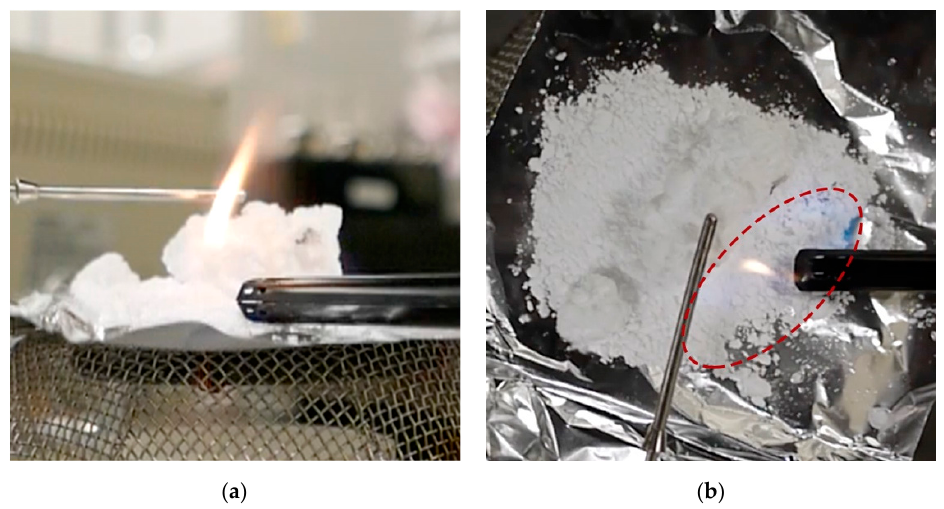
Figure 4. The snapshot at the moment when the methane hydrate was ignited by a butane lighter. The bright yellow flame was from a methane jet releasing from the hydrate block, shown in ( a ), while a pale blue flame was distributed around the hydrate powder with more air admixing into the methane released from this section of the sample in ( b ).